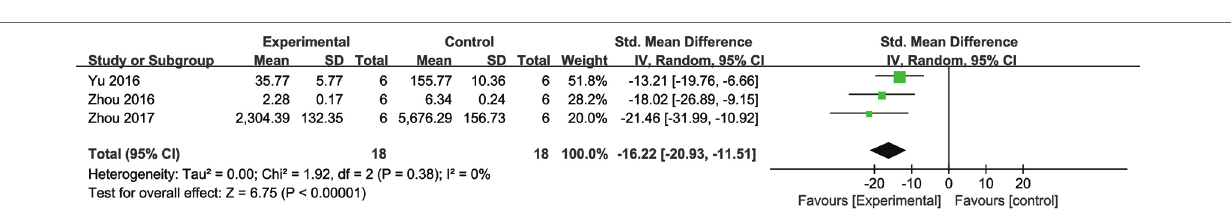
FIGURe 5 | The forest plot: effects of notoginsenoside R1 for reducing cardiomyocytes LDH release compared with the control group (n = 18 per group).